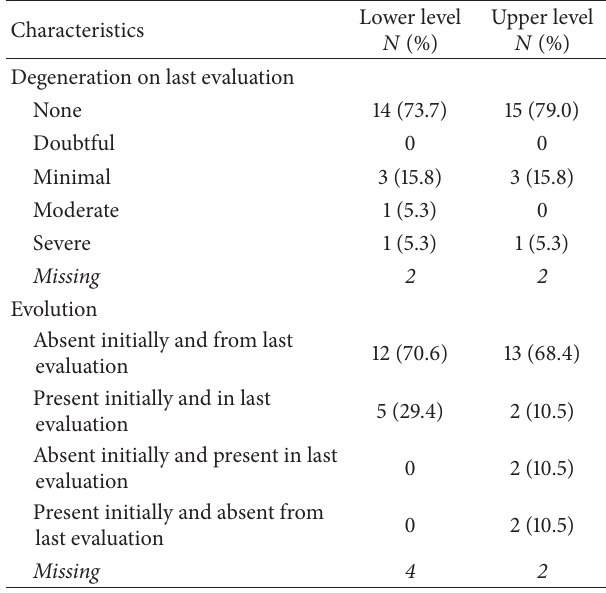
Table 2: Degenerative status of adjacent discs (above and below) at the final evaluation and compared to the initial